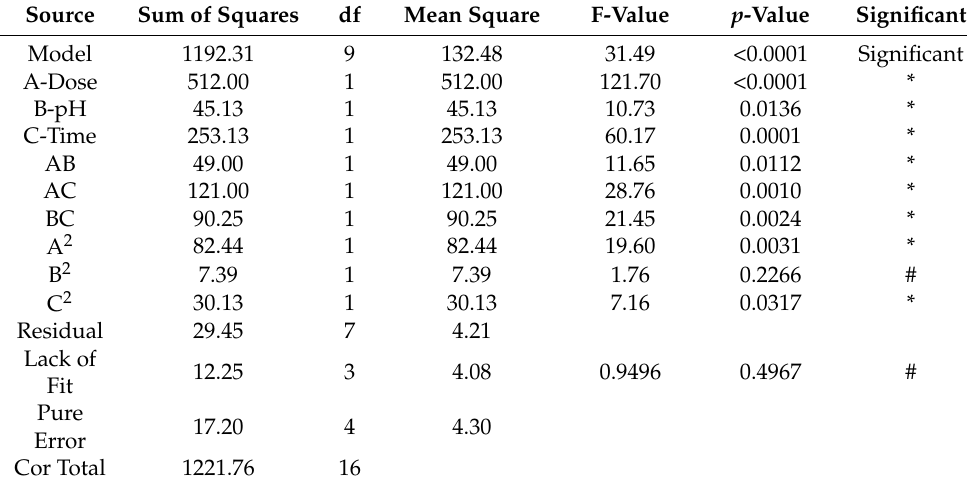
Table 4. Analysis of variance (ANOVA) for MB removal (%) by